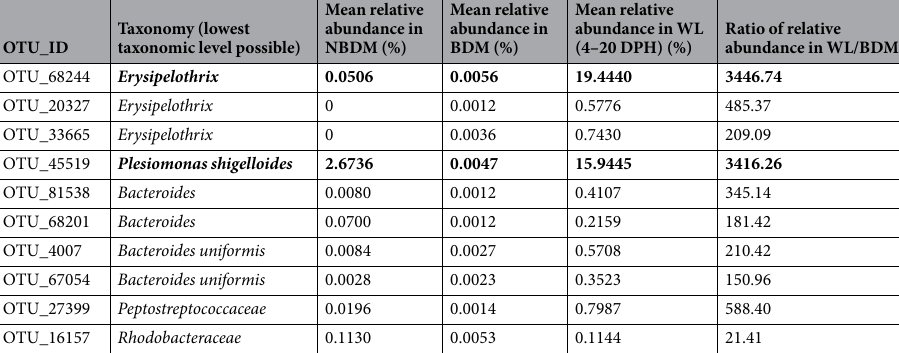
Table 3. Potential vertical transmission of microbial symbionts from parents’ skin mucus to fry through skin mucus feeding behavior (4–20 DPH). Taxa in this table: (1) are shared between breeding discus skin mucus and whole larvae microbiota during mucus feeding (4–20 DPH); (2) are absent from environmental water bacterioplankton; and (3) have a higher relative abundance in whole larvae during mucus feeding (4–20 DPH) than in breeding discus skin mucus, highlighting the differential niche preference of these microbial taxa. In this table, “WL” stands for “Whole Larvae”, “NBDM” stands for “Non-breeding discus mucus”, and “BDM” stands for “Breeding discus